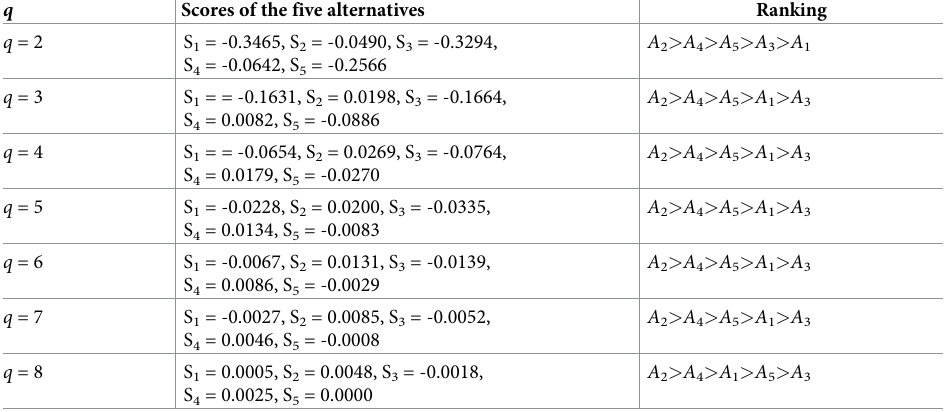
Table 6. The results of experiment